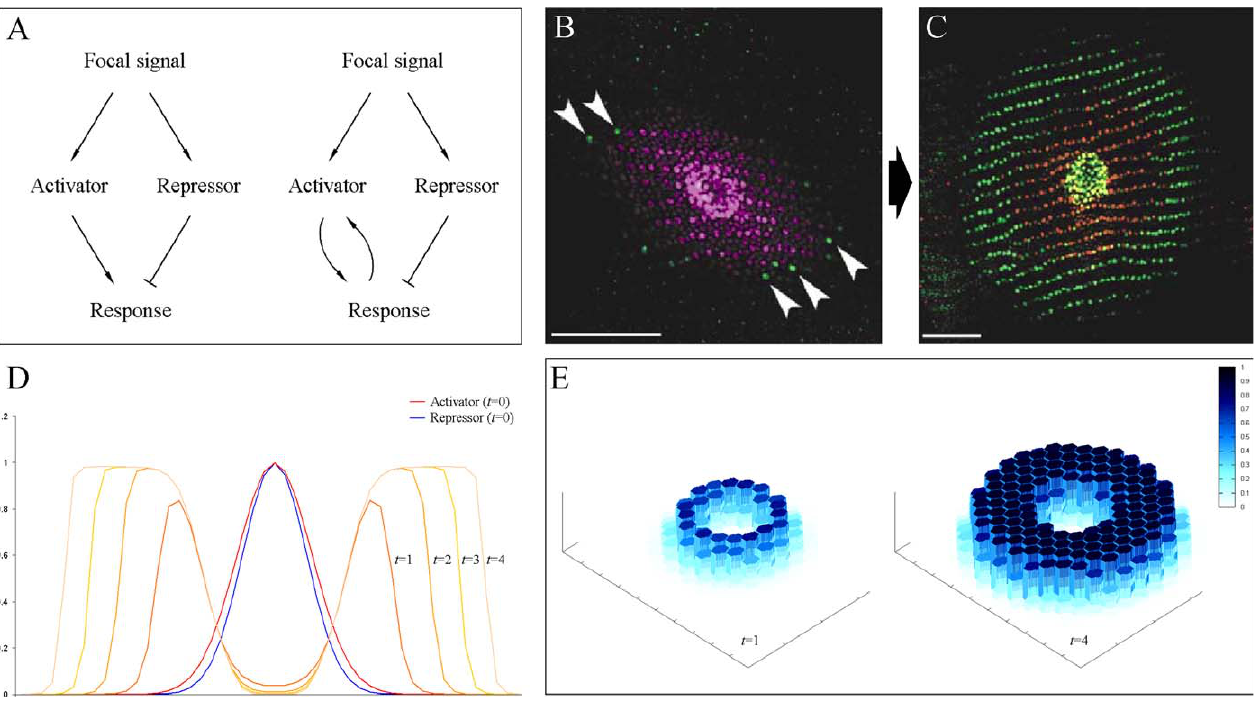
Figure 4. Possible Extensions of the Antagonistic Model (A) Feed-forward network motif (left) and the motif with a feedback to the activator (right). (B,C) Expansion of the engrailed expression pattern in the eyespot of the developing butterfly wing (image adapted from C. Brunetti [67]: engrailed expression, green; spalt expression, purple and red). White arrowheads signify initial engrailed pattern. (D) A dynamic model for the network motif with feedback reproduces the outward expansion of the engrailed ring in the eyespot. The initial response of engrailed is equivalent to that shown in Figure 2A; consequently. the engrailed extends itself ‘‘ outward ’’ from the focus. (E) 2.5-Dimensional plot of (D) for time points t ¼ 1 and t ¼ 4.